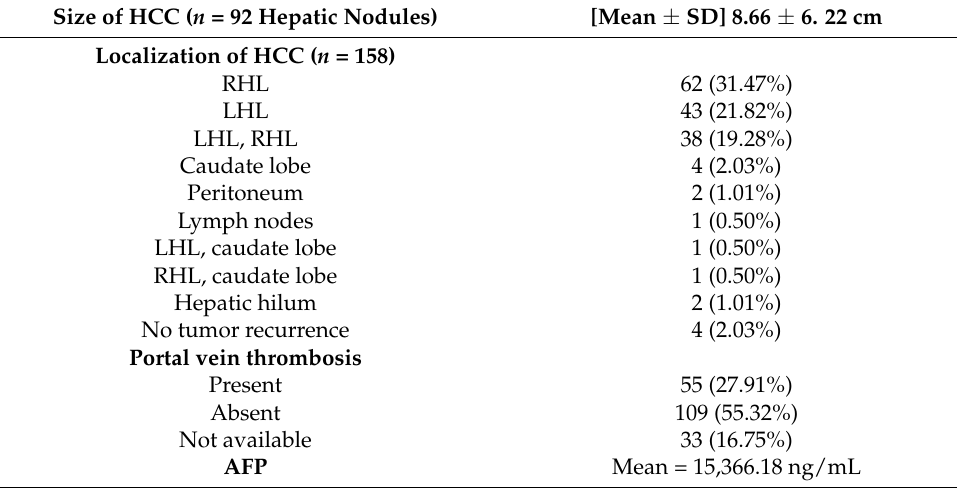
Table 4. Summary of clinical characteristics of study